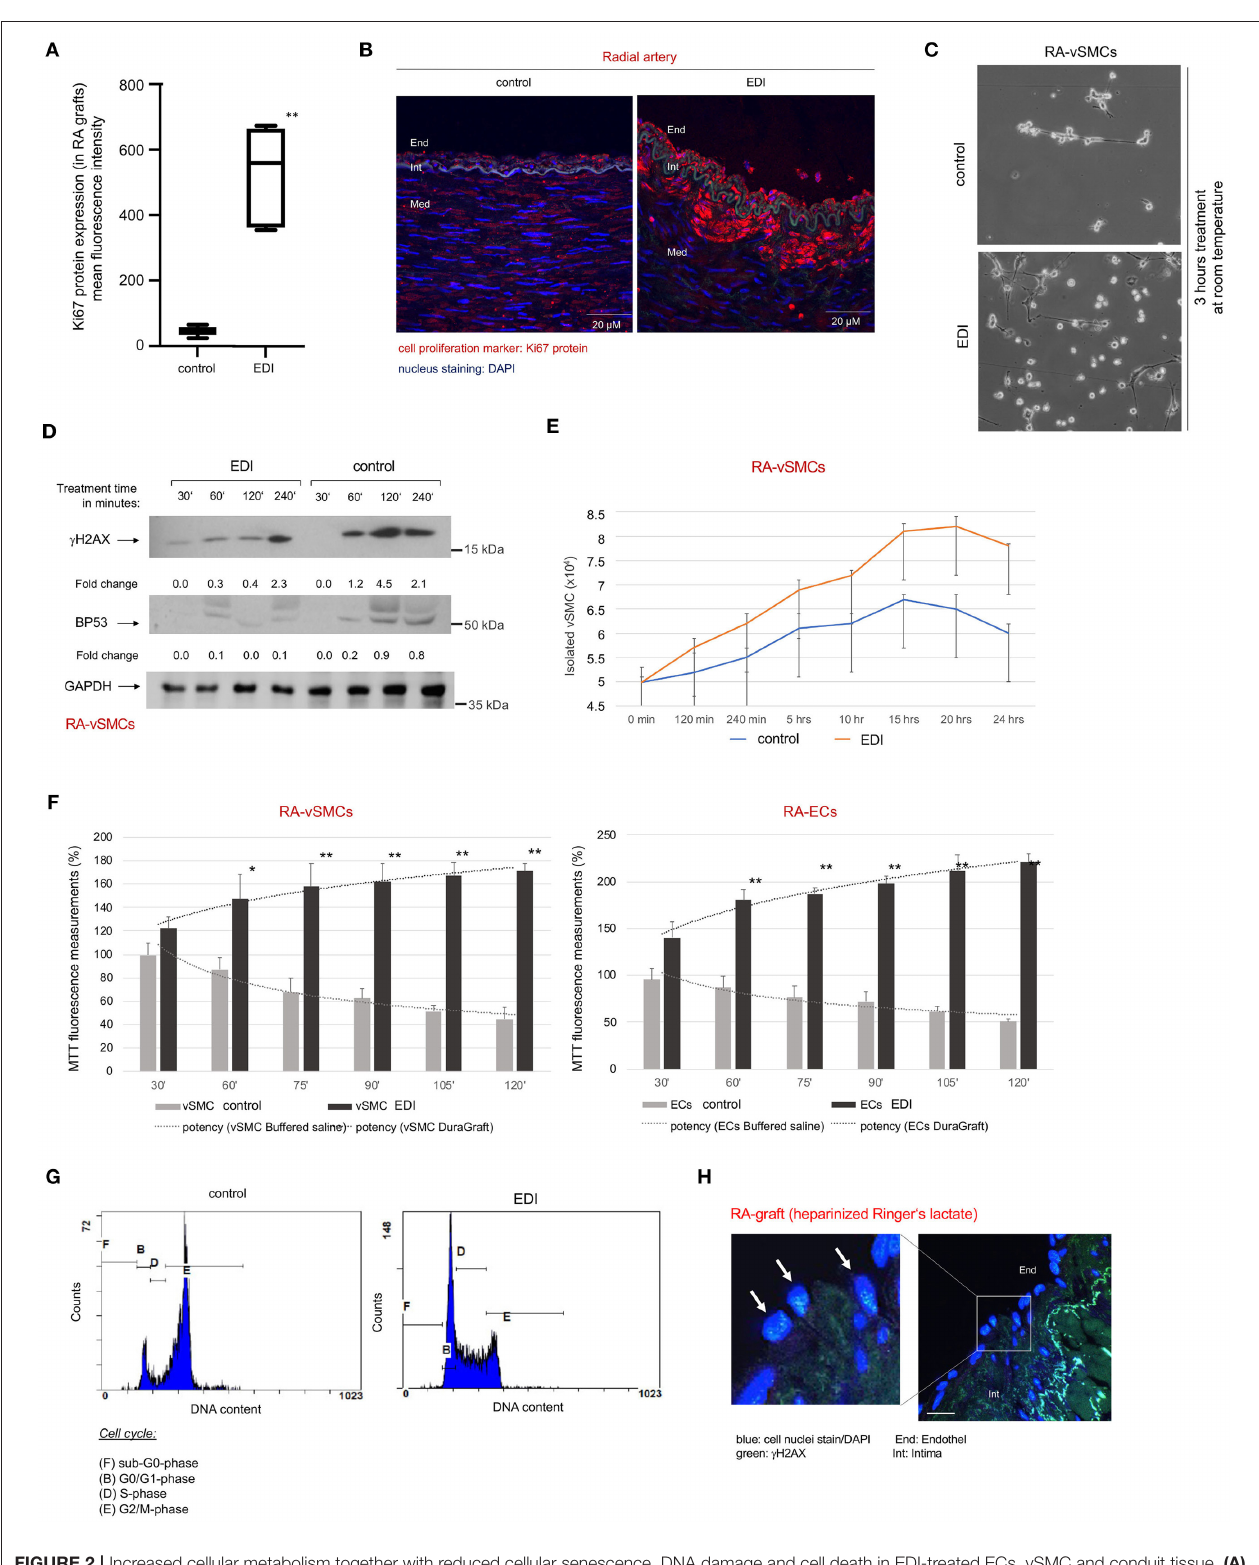
FIGURE 2 | Increased cellular metabolism together with reduced cellular senescence, DNA damage and cell death in EDI-treated ECs, vSMC and conduit tissue. (A) Statistical analysis and (B) Representative image of Ki67 IF staining in RA grafts after treatment with RL or EDI. ** p < 0.01; End, endothel; Int, intima; Med,